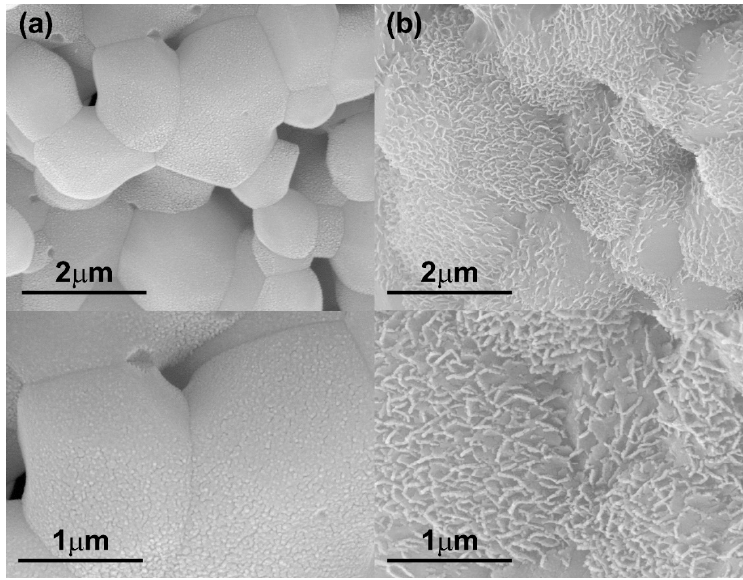
Figure 10. FESEM micrographs of HA scaffolds after 30 days of soaking in SBF at different magnification. The scaffolds were sintered at 1200 °C and using a ) 20 wt.% of slurry solid content, b ) 40 wt.% of slurry solid content.